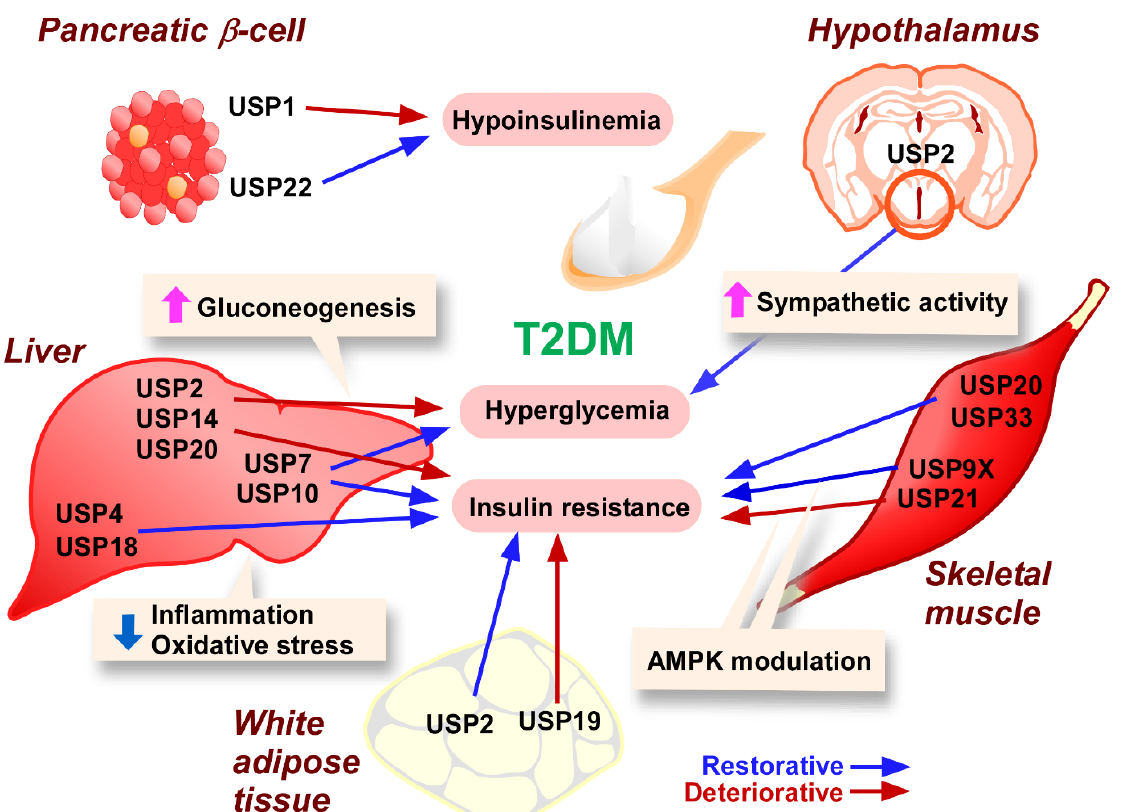
Figure 1. Roles of ubiquitin-specific proteases (USPs) in type 2 diabetes mellitus (T2DM). Blue and red lines represent restorative and deteriorative effects on T2DM, respectively.